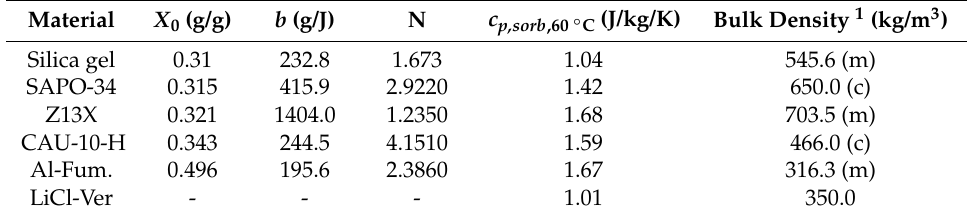
Table 2 Key information on the investigated materials; measured (m) and calculated (c) from the measured density of the powder, assuming close-packing of equal spheres with 74% of solid volume.